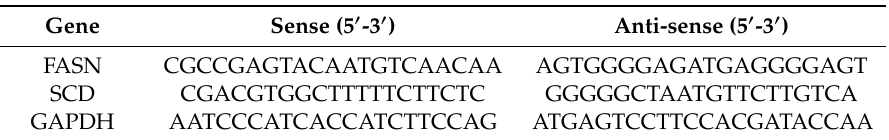
Table 1. Primers for RT-PCR.